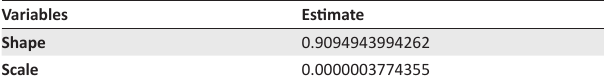
FIG URE 1: (a) Kernel density estimator and (b) empirical cumulative density function of apartment TABLE 2: Shape and scale parameters for the apartment price distribution.